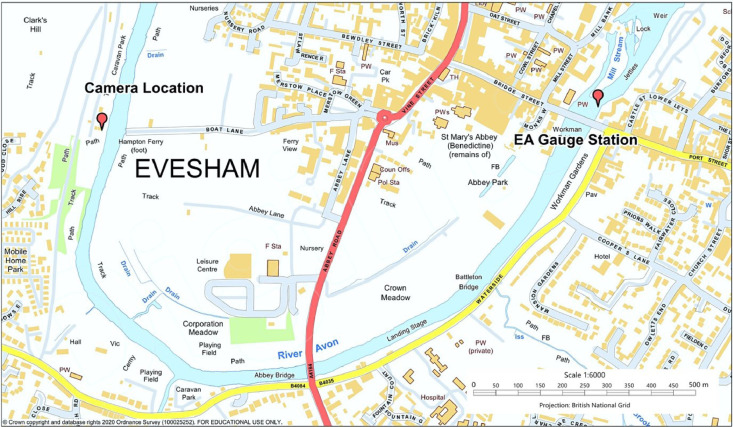
Map illustrating the Evesham camera on river Avon and nearest EA river gauge 'Evesham' (labelled red teardrop shape markers). The map projection is British National Grid and the map scale is given in the bottom right. The vertical is aligned with true North. Produced using EDINA Digimap Ordnance Survey Service, Date created: 09/03/2020. (For interpretation of the references to colour in this figure legend, the reader is referred to the web version of this article.)